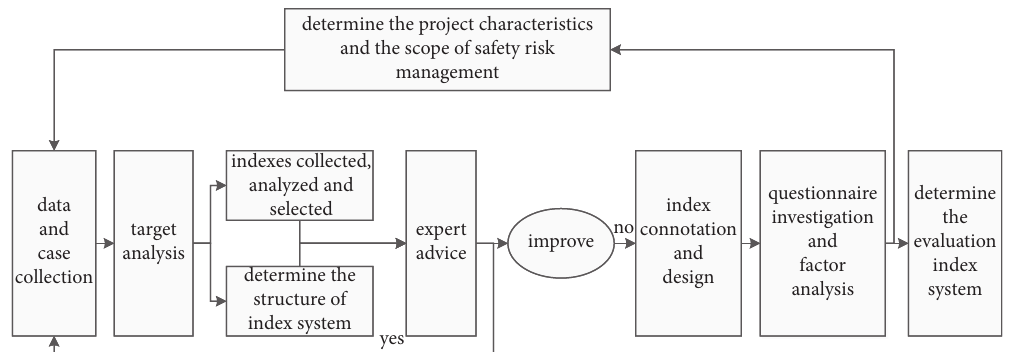
Figure 5: The establishing process of evaluation index system of safety risk. Table 1: The evaluation index system of safety risk in construction site [1, 2,